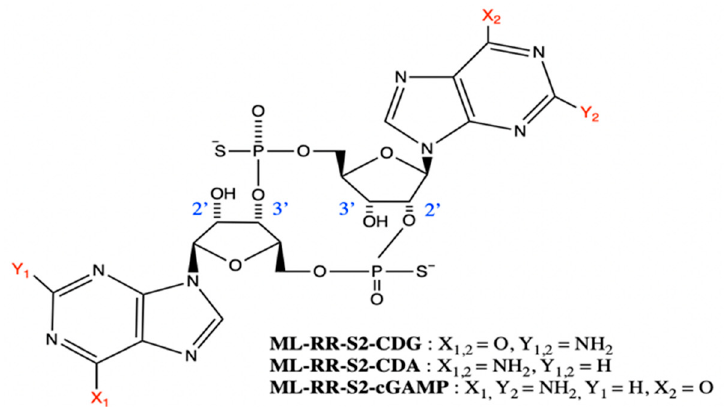
Figure 4. Structures of synthetic cyclic dinucleotide derivatives developed by Gajewski et al. [20]. Substituents X1, X2, Y1, and Y2 are shown inset. An original figure created with ChemDraw.